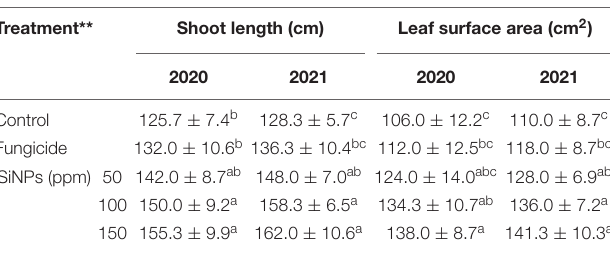
TABLE 3 | Effects of foliar application of SiNPs on vegetative growth parameters of grapevines infected with downy mildew at 15 days post the fourth spray.* Treatment** Shoot length (cm) Leaf surface area (cm 2